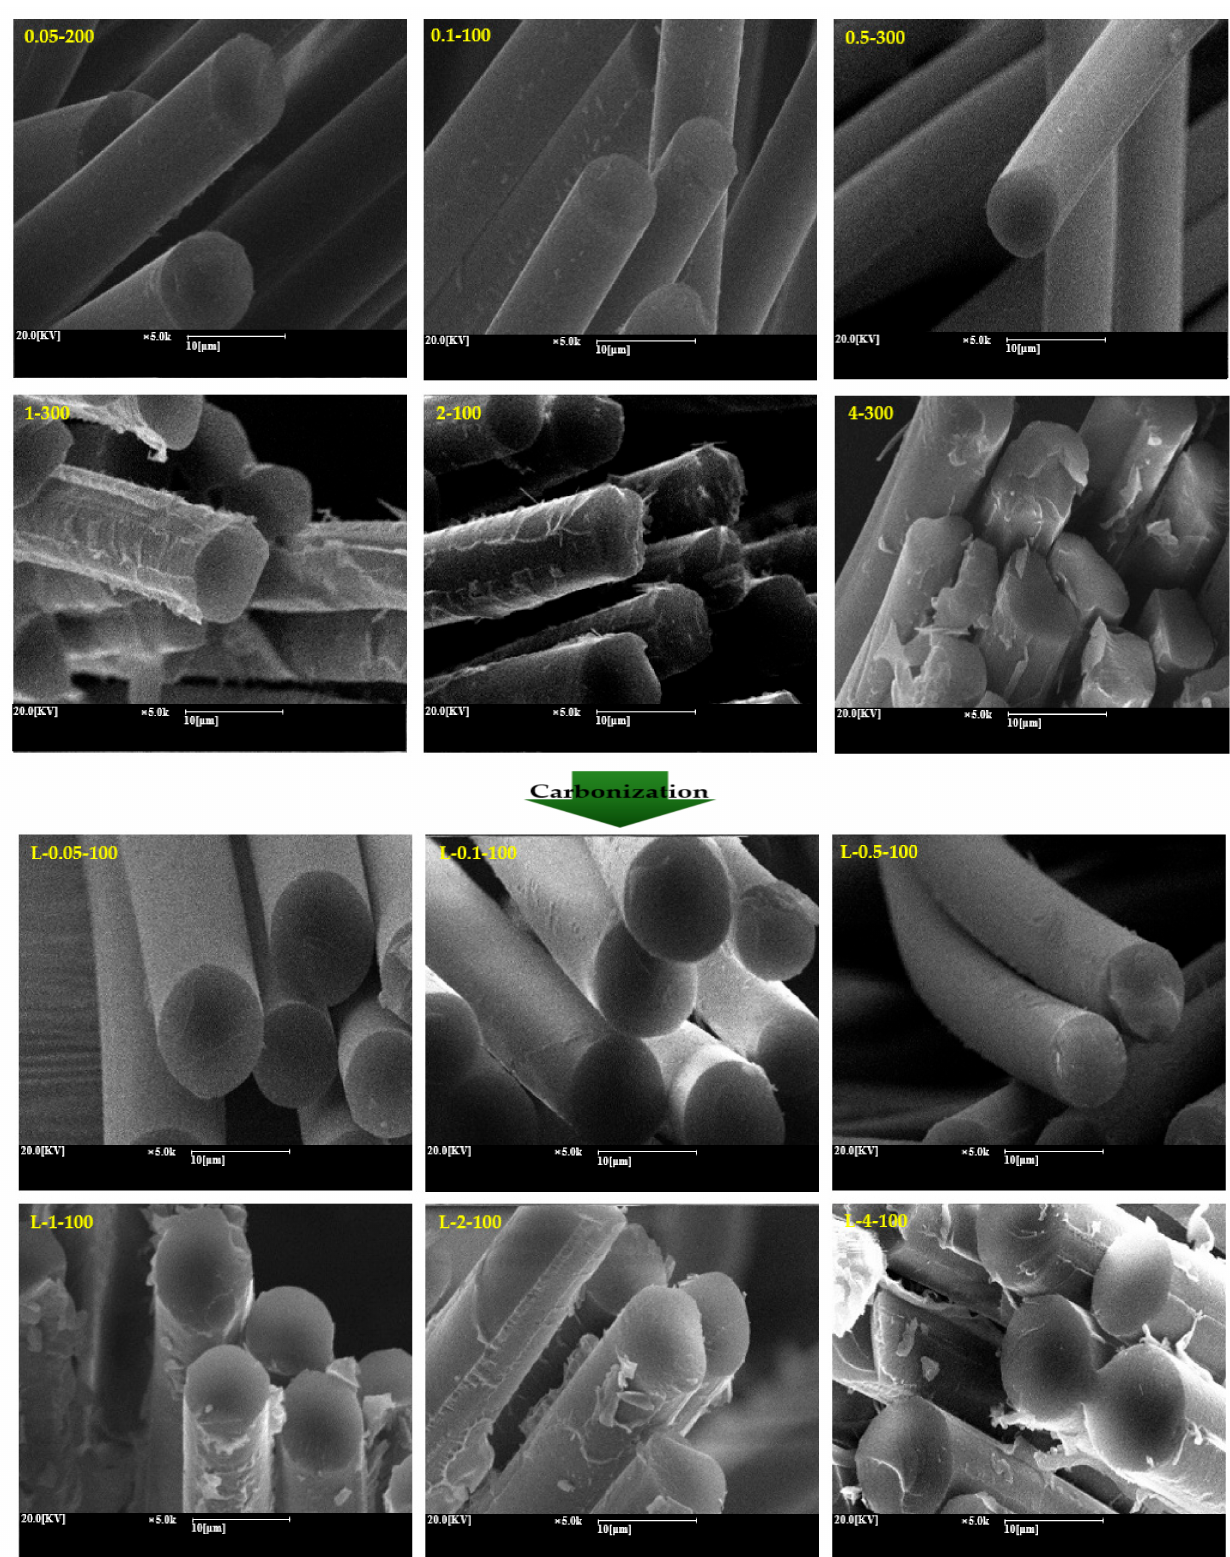
Figure 4. SEM images of raw lyocell, lyocell grafted with PAM of different concentrations via EBI, and PAM-grafted lyocell after stabilization and